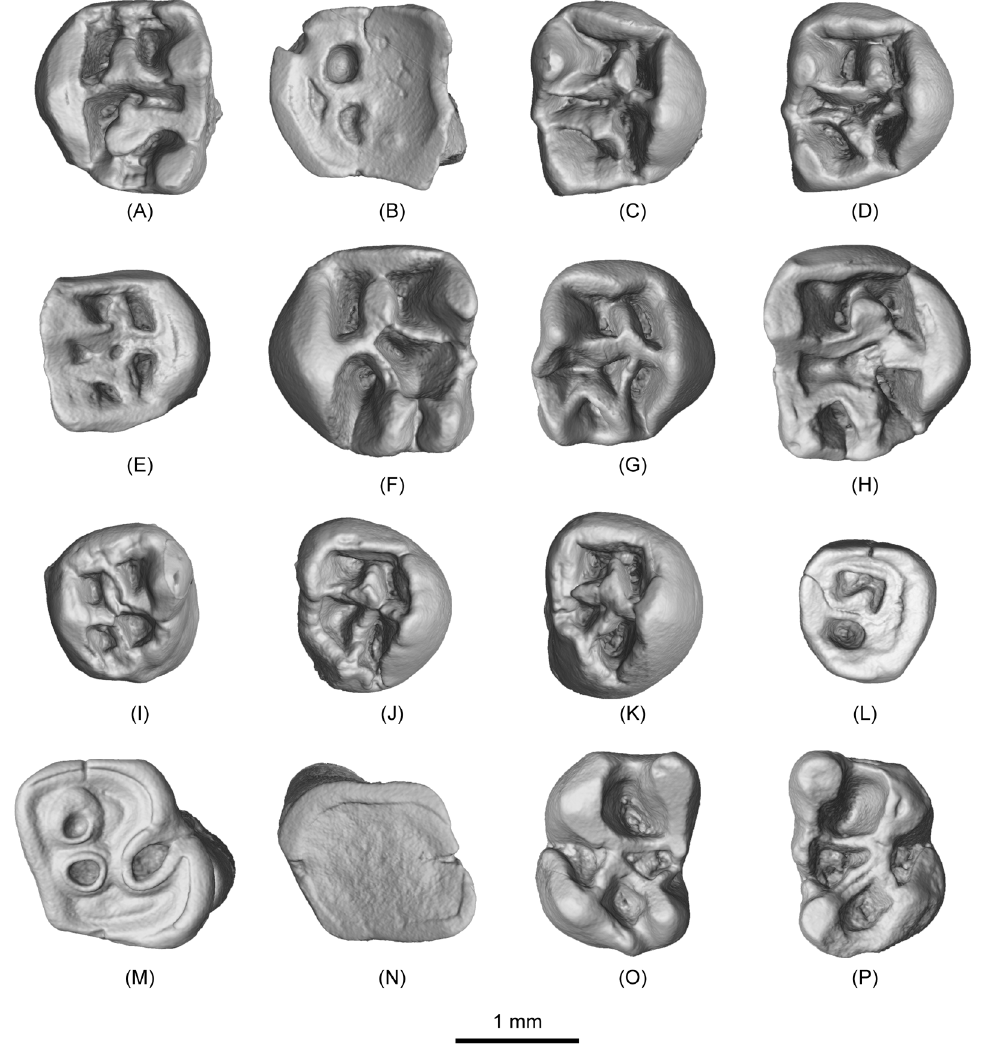
Fig 2. Upper and lower teeth of Irtyshogaulus minor gen. et sp. nov. (A), V 20328, left M1 (holotype); (B), V 20329.1, left M1; (C)-(E), V 20329.2 – 4, right M1s; (F), V 20329.5, left M2; (G)-(H), V 20329.6 – 7, right M2s; (I), V 20329.8, left M3; (J)-(L), V 20329.9 – 11, right M3s; (M)-(N), V 20329.12 – 13, right m1s; (O), V 20329.14, left m2; (P), V 20329.15, right m2; Scale bar, 1 mm.